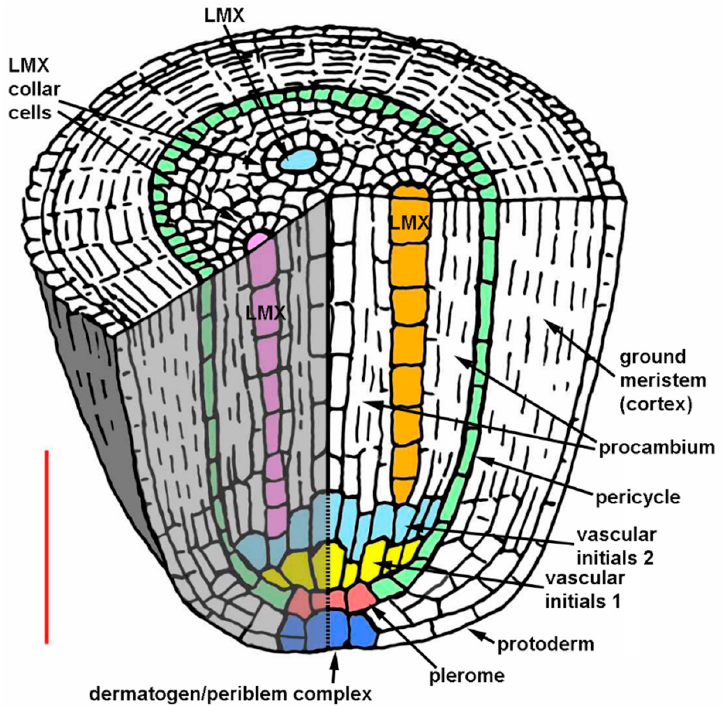
Figure 4. Schematic diagram of the promeristem and primary meristem of Zea primary roots. Highlighted with colors are the dermatogen-periblem complex, plerome, and vascular initials layers, the pericycle, and late-maturing metaxylem vessels (LMX) with their associated distinctive collar cells. The calyptrogen and root cap tissue are not shown. Scale bar = 100 µm.